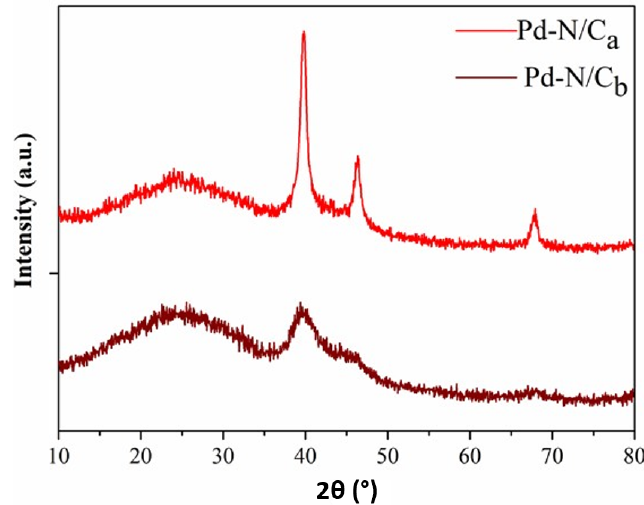
Figure 2. XRD pattern of the prepared Pd-N/C materials.